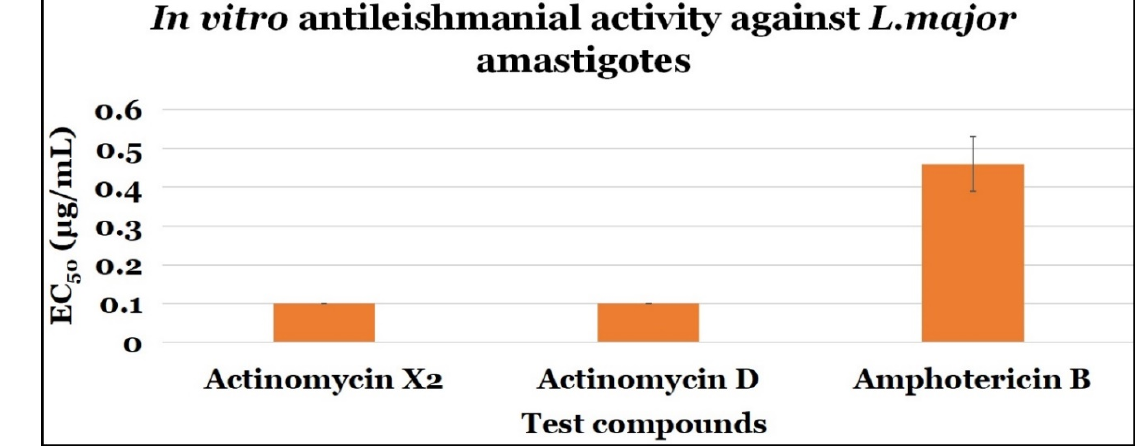
Figure 5. The anti-amastigotes activity of the tested compounds.